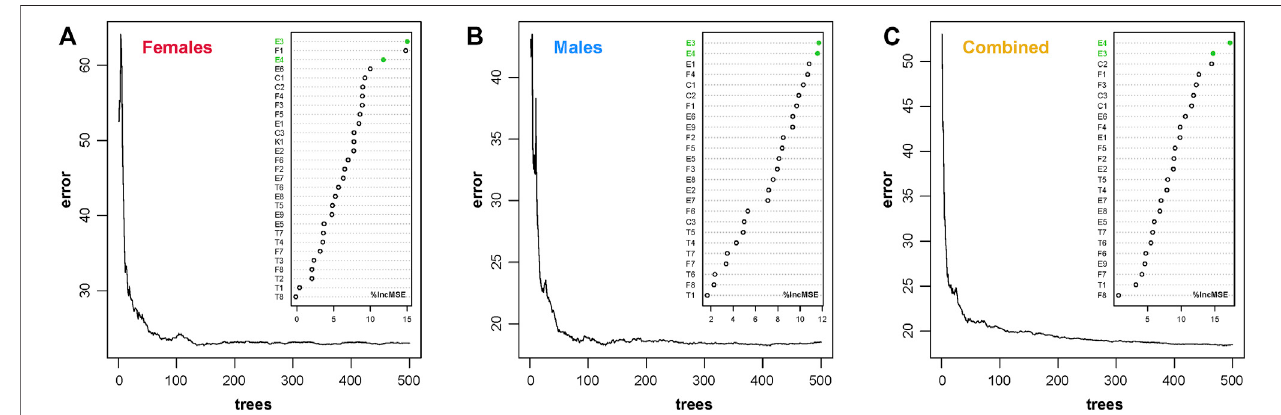
FIGURE 3 | Validation of feature selection ( ntree (cid:1) 500) and AR-CpG importance ranking in three different gender datasets of the CHS cohort ( n (cid:1) 240, blood samples). (A) Femaledataset( n (cid:1) 132). (B) Maledataset( n (cid:1) 108). (C) Combineddataset( n (cid:1) 240).( ntree ,numberoftreestogrow,whichshouldnotbesettotoosmall a number, to ensure that every input row gets predicted at least a few times; %IncMSE , increase in mean squared